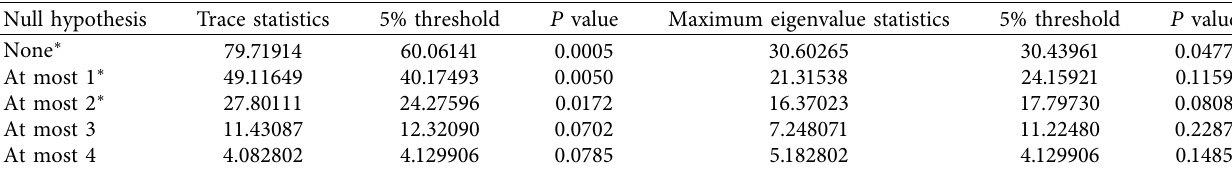
Table 4: Johansen co-integration test results.